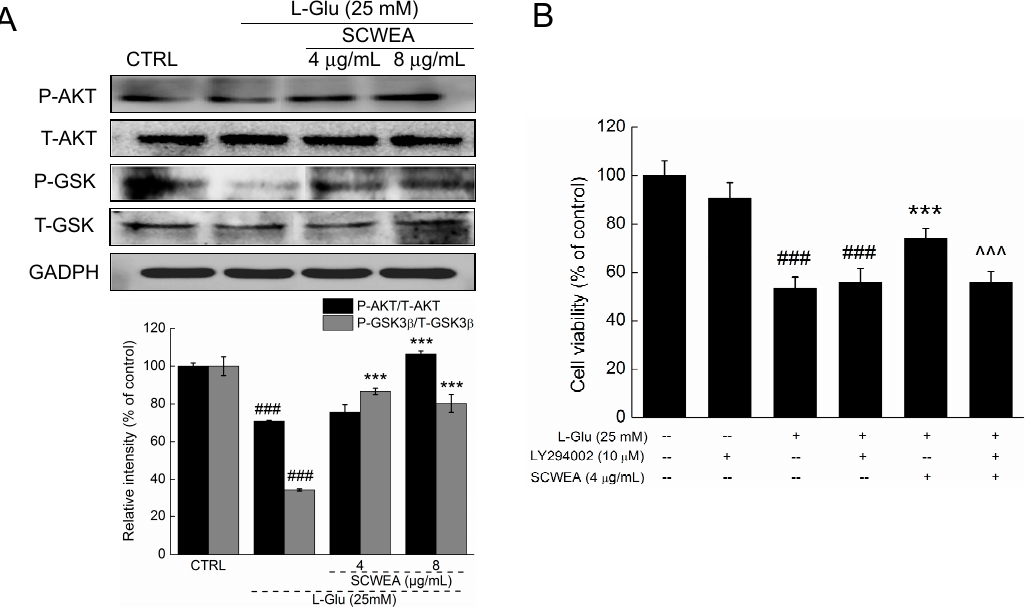
Figure 6. AKT/GSK3 β pathway contributes SCWEA-mediated neuro-protective effect. DPC12 cells were pre-treated with 4 and 8 µg/mL SCWEA for 3 h, followed by exposure to 25 mM glutamate for 24 h. ( A ) The activation of AKT and GSK-3 β was detected via Western blot. Quantification data were normalized by corresponding T-AKT and T-GSK3 β , respectively; ( B ) Protective effects of SCWEA against L -Glu on cell viability were abolished by LY294002 pre-treatment. DPC12 cells were pre-treated with 10 µM LY294002 for 30 min, followed by treatment with 4 µg/mL SCWEA for 3 h and exposure to 25 mM L -Glu for 24 h. Data were expressed as a percentage of corresponding control cells and means ± S.D. ( n = 6). ### p < 0.001 versus control cells; *** p < 0.001 versus L -Glu-exposed cells; ^^^ p < 0.001 versus SCWEA and L -Glu co-treated cells.